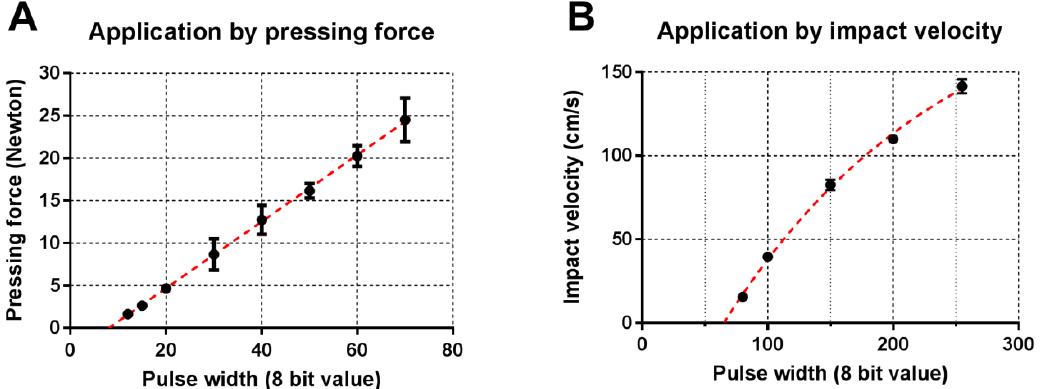
Figure 7. Regression curves used to set the applicator’s pulse width as a function of the chosen pressing force ( A ) and impact velocity ( B ) at a pulse frequency of 10.5 kHz. Data are shown as mean ± SD, n = 3 ( A ) and n = 10 ( B ).